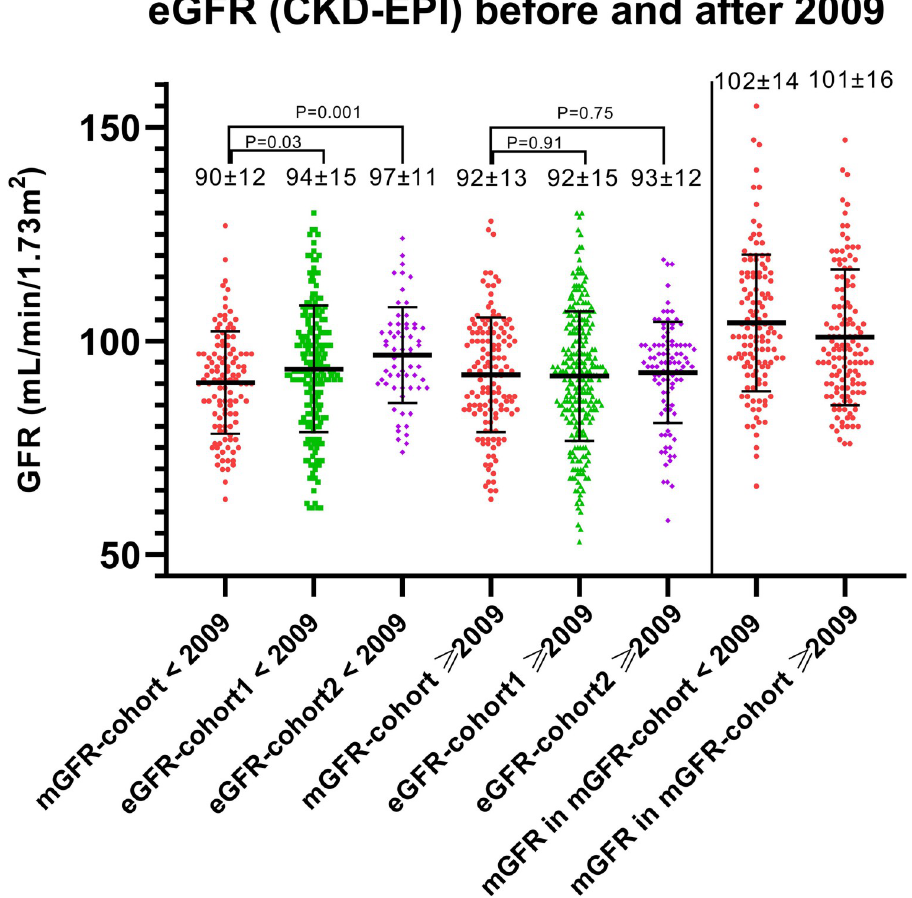
Fig 3. Distribution of pre-donation eGFR (CKD-EPI) before and after 2009 per center. Differences between mean pre-donation eGFR were tested using the independent sample T-test, P-values are shown in the Fig. Distribution of mGFR in the mGFR-cohort was added on the right in the